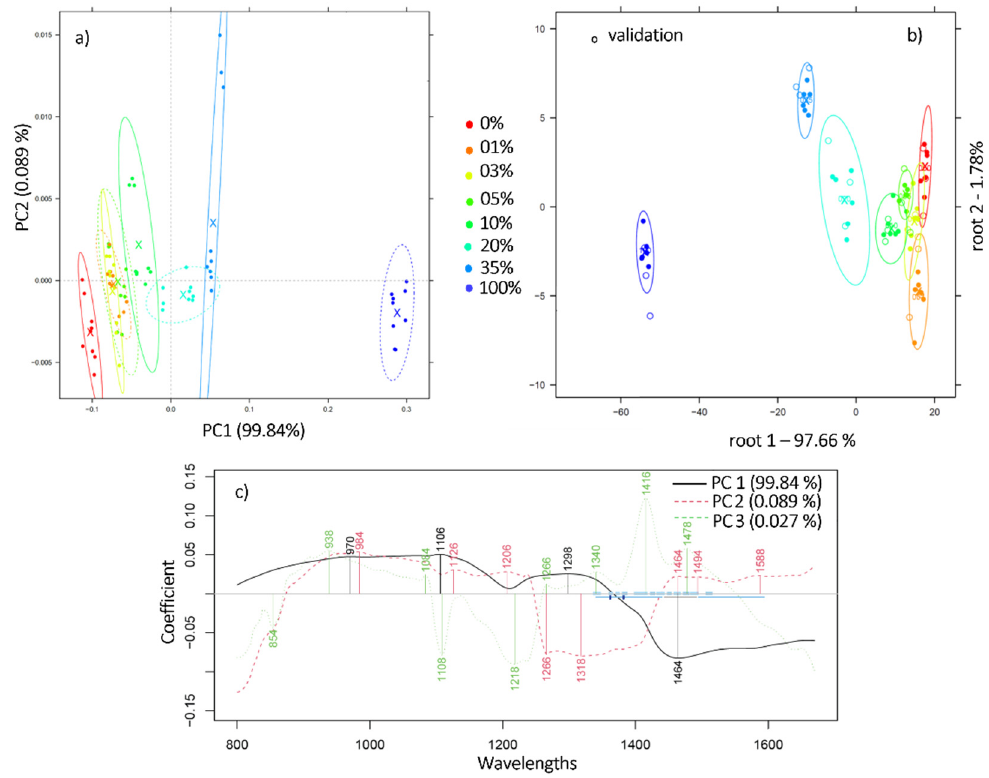
Figure 2. ( a ) PCA scores plot reveals separation along PC1 axis of the mixtures containing Robusta concentration in the range 1%–35%, N = 72, wavelength range 800–1670 nm, Savitzky-Golay smoothing (window size 19) and MSC; ( b ) PCA-LDA classification plot of the robusta adulterated ground coffee in the concentration range 1%–35%, wavelength range 1300-1600 nm, N = 72; ( c ) PCA loadings